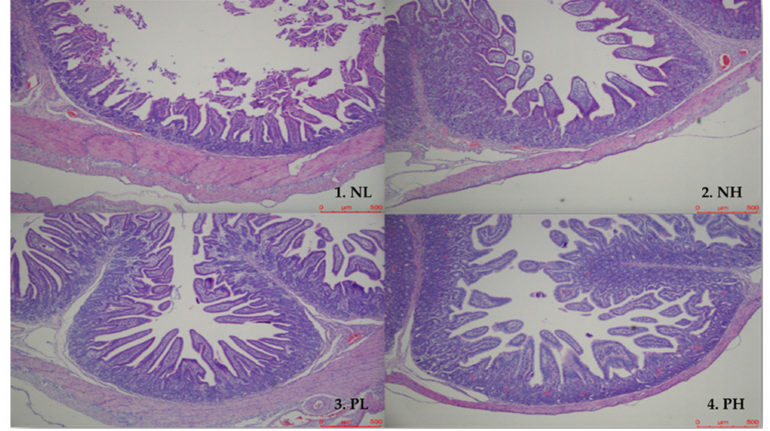
Figure 1. Comparison of jejunal microscopical photographs with histological staining of weaning piglets. NL, adding 7.5% water before corn extrusion; NH, adding 15.0% water before corn extrusion; PL, adding 7.5% water and 4 kg/t α -amylase before corn extrusion; PH, adding 15% water and 4 kg/t α -amylase before corn extrusion.